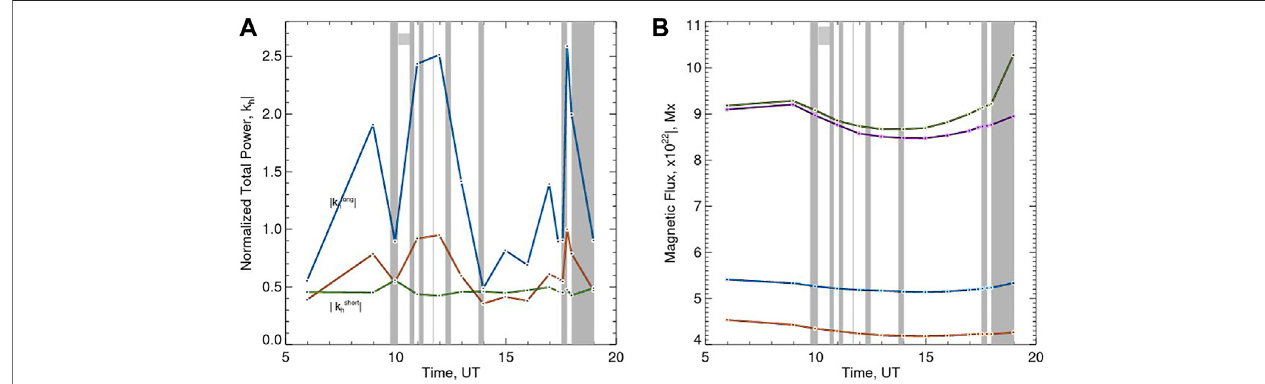
FIGURE8|(A) :Timevariationsofsign-singularityparameterscalculatedforcurrenthelicitymapsobtainedfromobservedvectormagnetograms.Thethreecurves showtimevariationsofthetotalpower(brown),thecancellationexponent( k short T ,green),andtheslope( k long T ,blue). (B) :TimevariationsofthemagnitudeofHMImagnetic fl ux calculated over the entire area shown in Figure 1 . Blue and orange pro fi les show data for northward and southward B represent horizontal B x and B y fl ux. In both panels the vertical strips indicate the start time and the duration of AIA 17.1 nm brightenings and the X1.2 fl are (18:00- 19:00UT)associatedwiththeAR fi lament,whilethehorizontalbarbetween10:07and 10:37UTmarksthetimingofaM7.2 fl